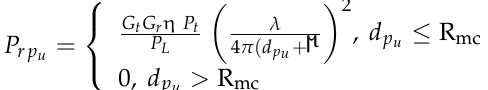
Figure 1. Network model and components